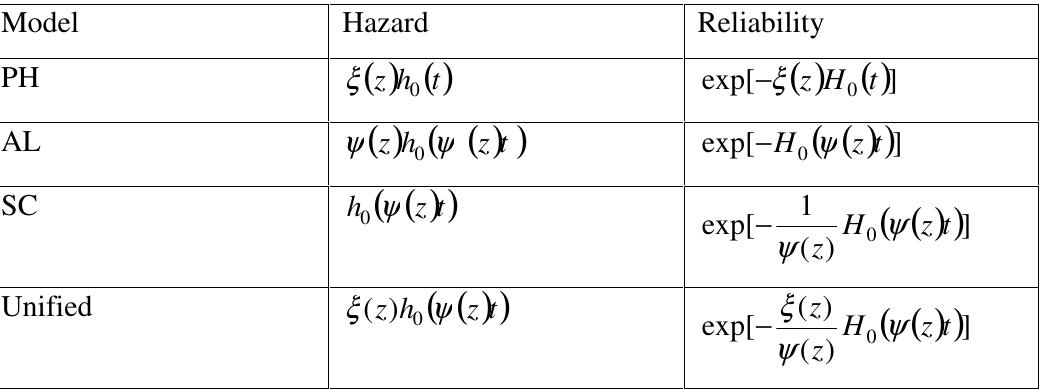
Table 6: A summary of covariate